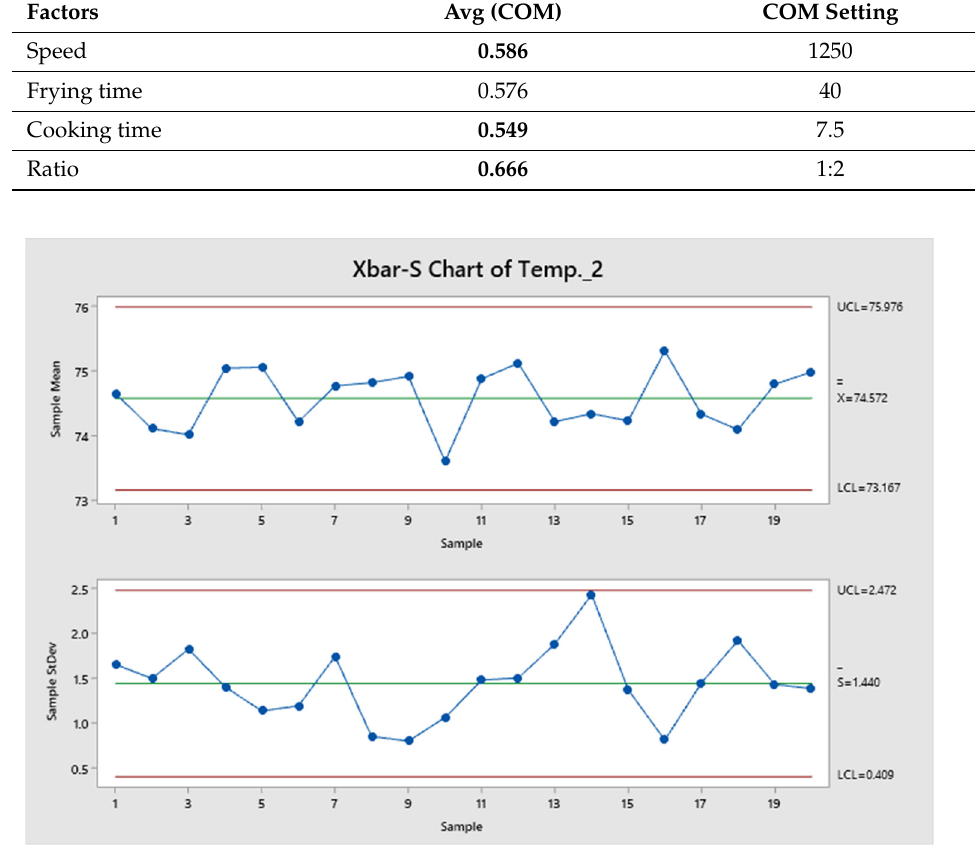
Figure 9. X - bar-S control chart for temp. response . Figure 9. X-bar-S control chart for temp. response.